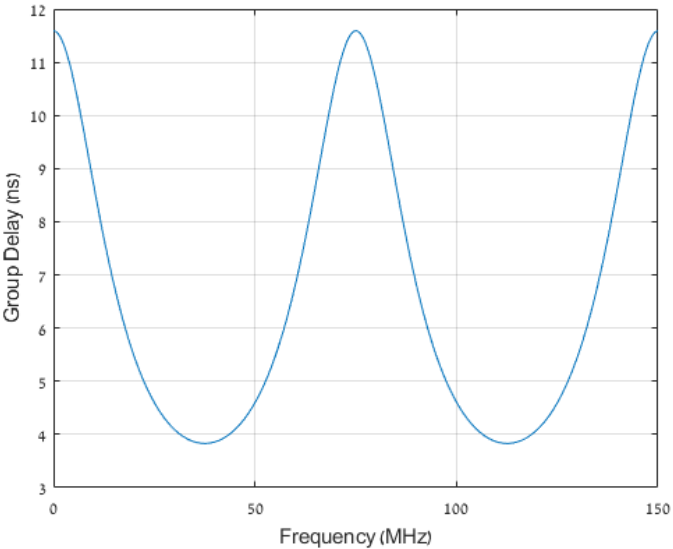
Figure 3. The group delay contributed by propagation through a two-meter-wide cavity when r as = − 0.5195, as predicted by our model.